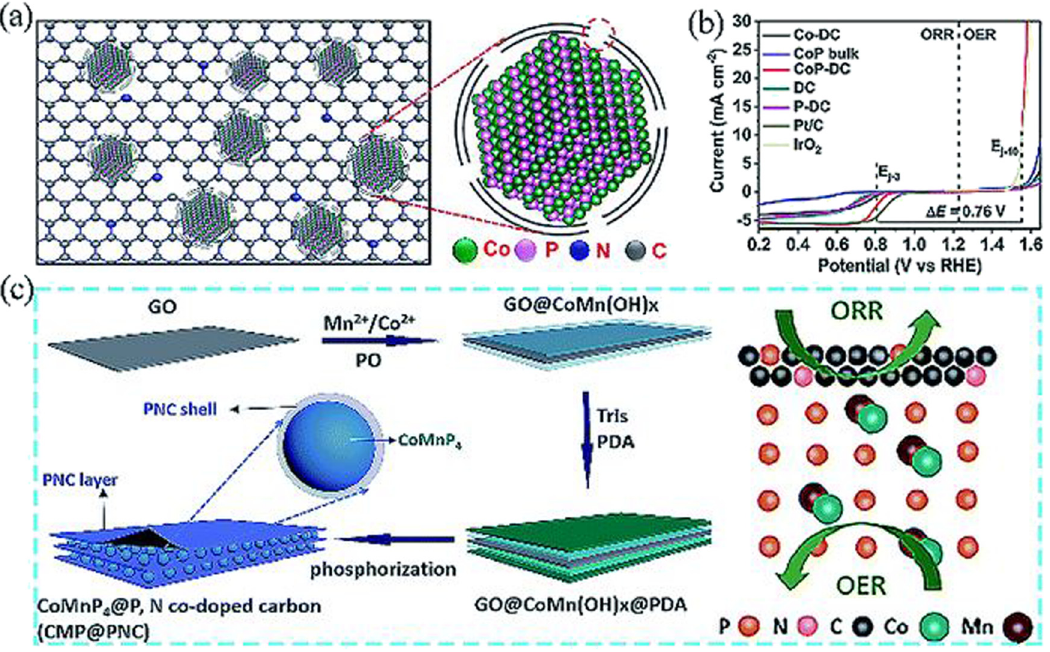
Figure 4: ( a ) Schematic illustration of the CoP – DC framework ( b ) The complete linear sweep voltammetry bends of the CoP – DC model over the entire ORR and OER areas in basic solution ( 0.1 M KOH ) . Redrawn from ref. [ 93 ] , copyright 2018, WILEY - VCH. ( c ) Synthesis of the enclosed bimetallic phosphide - type CMP@PNC catalyst, and a diagram of the ORR and OER - sites. Redrawn from [ 95 ] , copyright 2018, Royal Society of